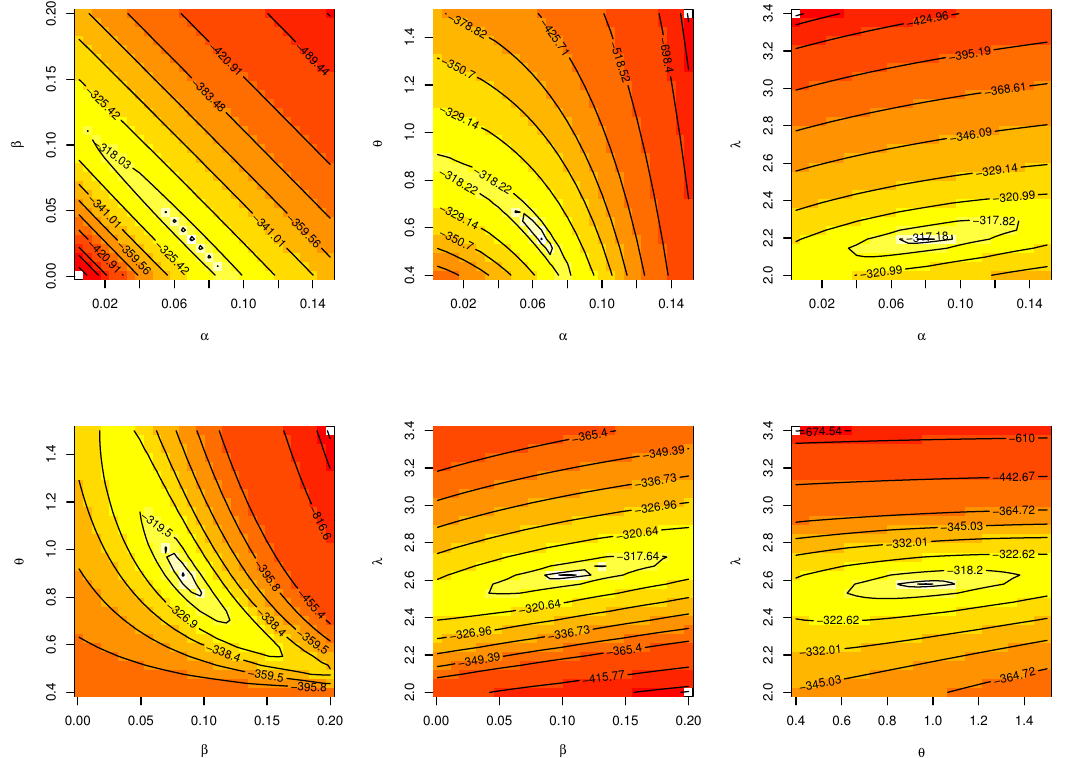
Figure 20. Contour plot for parameters of TLMW model for waiting